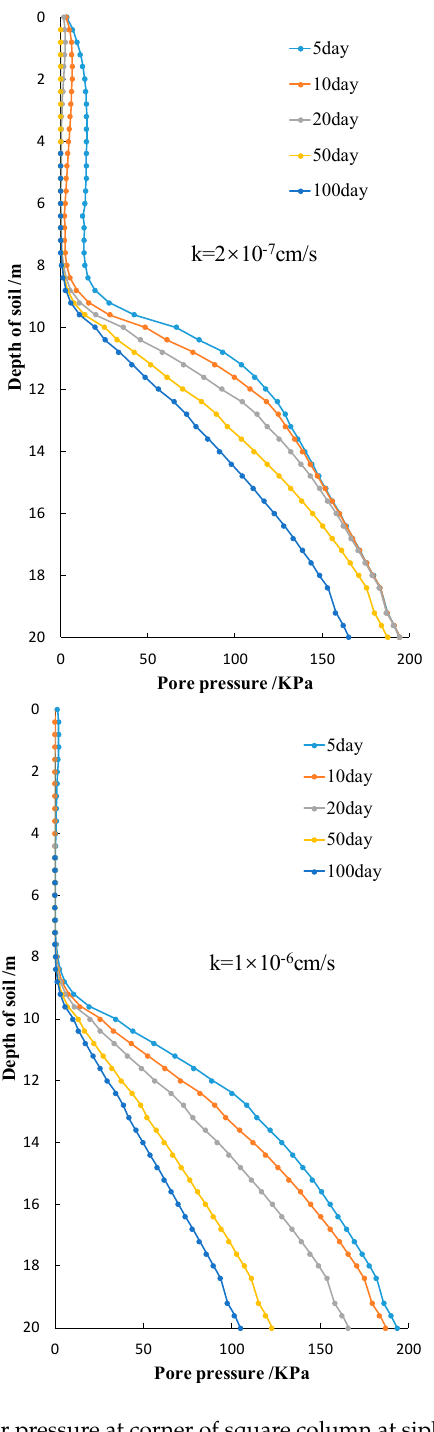
Figure 7. Under the siphon drainage, the pore pressure is always decreasing. When the siphon drainage begins, the pore water pressure drops rapidly at first. Then, as time increases, the pore water pressure decreases